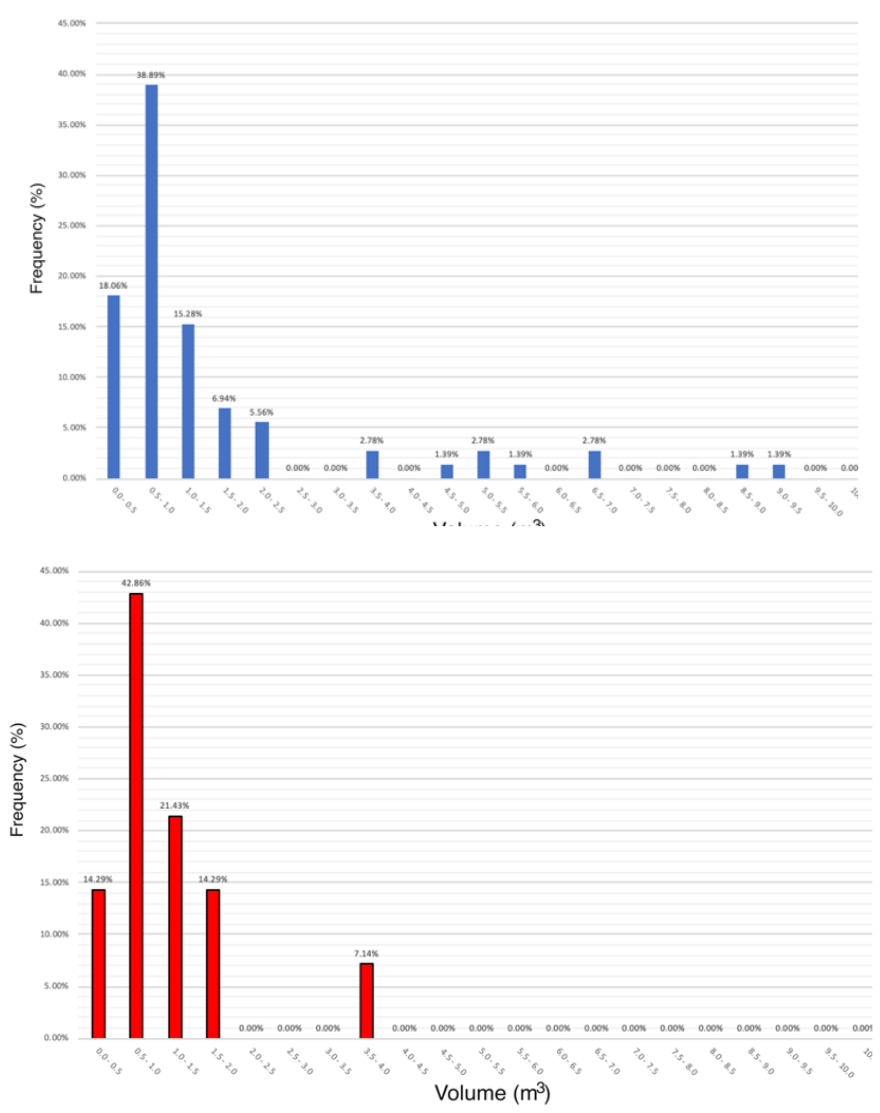
Figure 18. Volume distribution for both the fallen (blue) and the potentially unstable (red) blocks for sub-region U4.